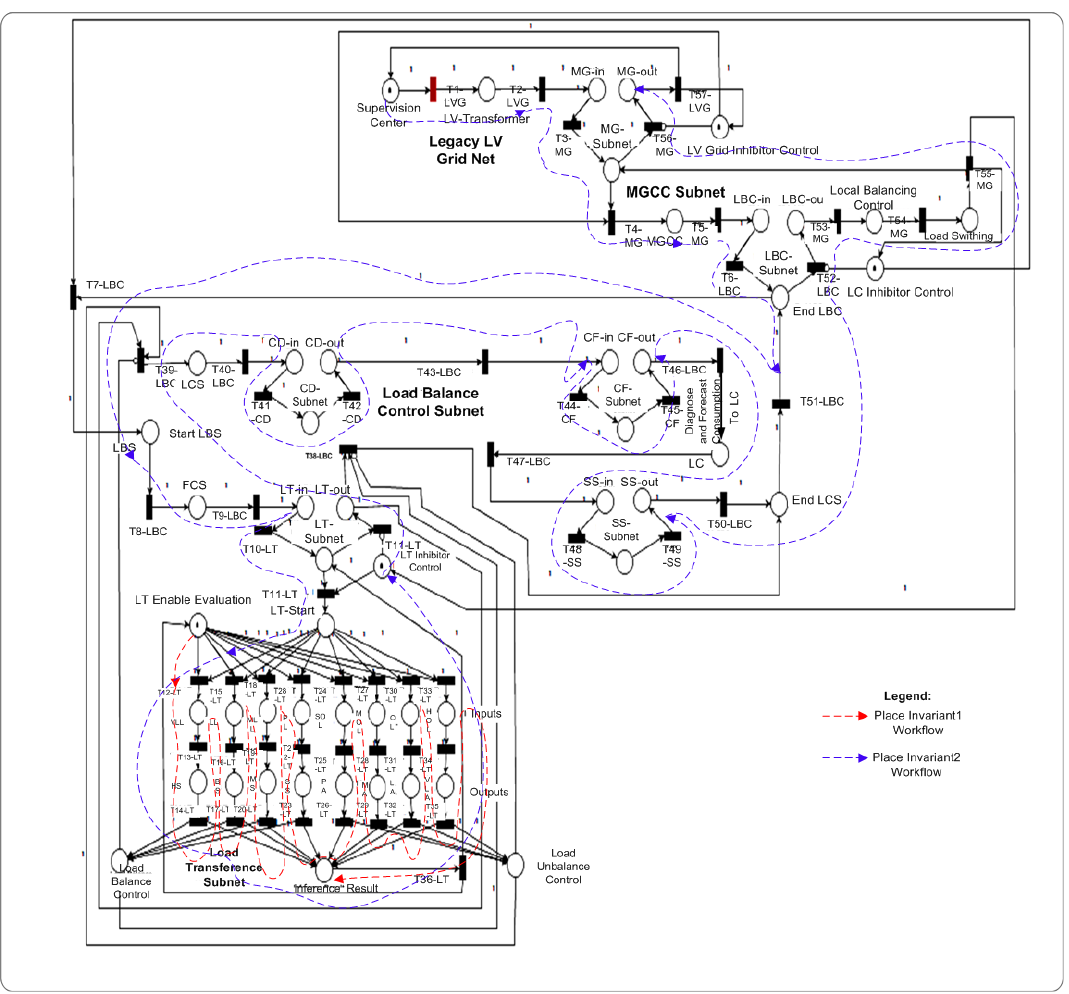
Figure 9. HPN Place-invariant workflow